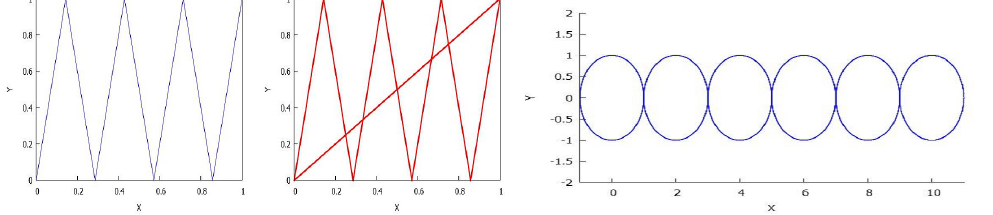
Figure 31. The map ϕ 6 and the ω -limit set ω Φ